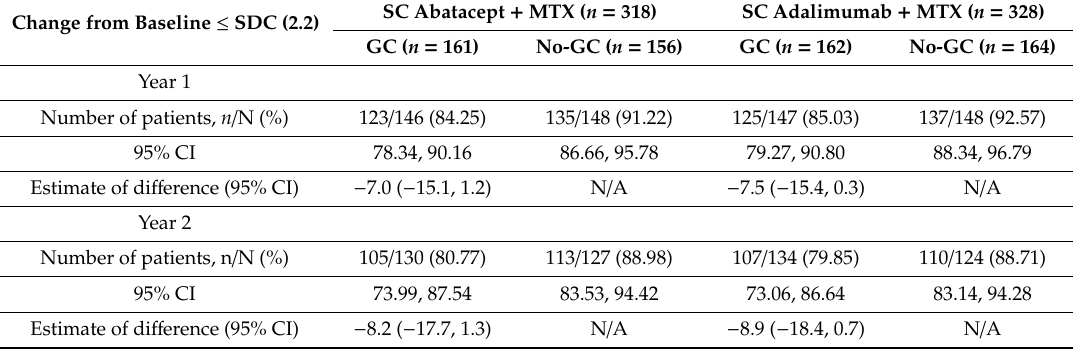
Table A2. Proportion of patients without radiographic progression in total Sharp score at Years 1 and 2 a . Change from Baseline ≤ SDC